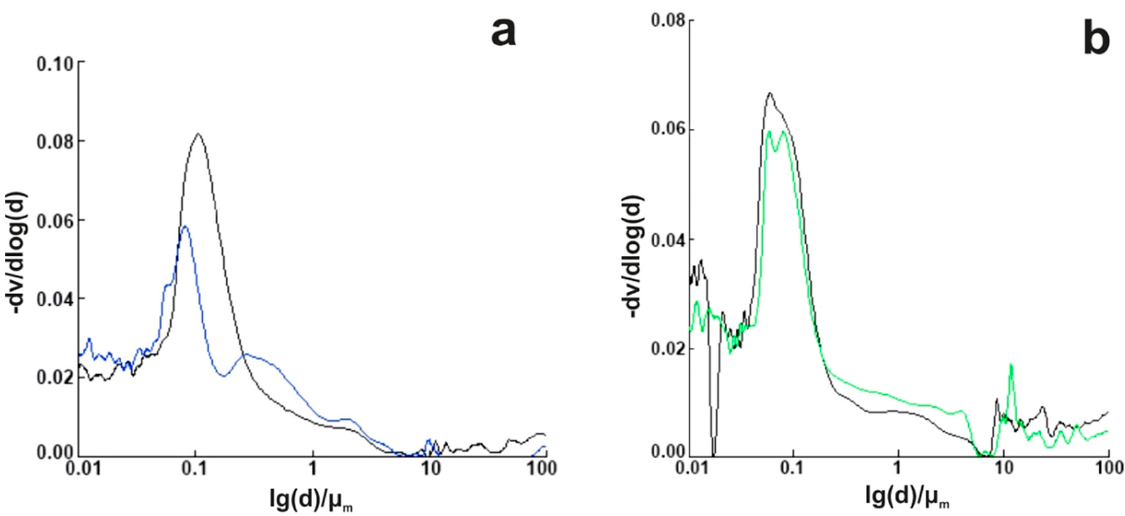
Figure 11. Pore size distribution of mortars containing MEA: ( a ) 4% MEA; ( b ) 8% MEA.